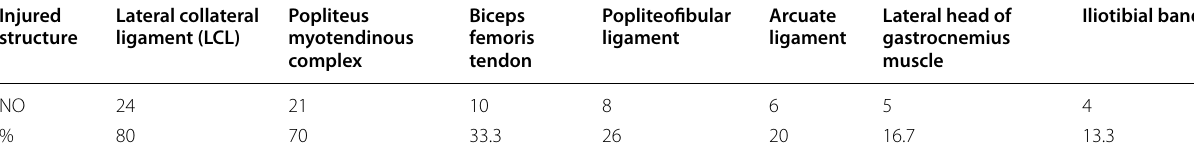
Table 2 Incidence of different PLC structures affected in all PLC‑injured studied cases Injured